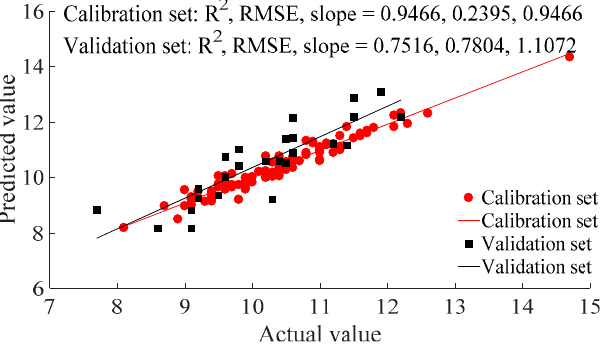
Figure 8. PLSR detection results of TSS based on fusion data.